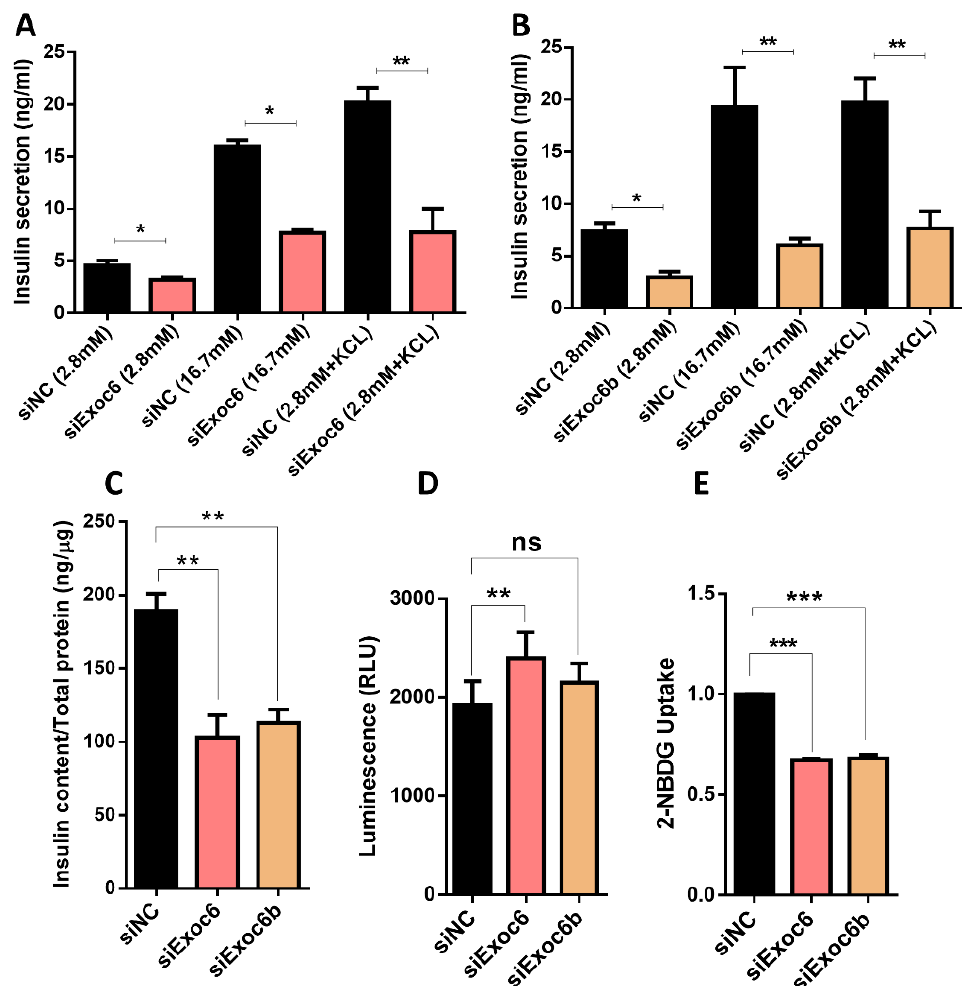
Figure 3. Impact of Exoc6/6b silencing on insulin release in INS-1 cells. ( A , B ) Measurement of insulin secretion (normalized to cellular protein content) stimulated with 2.8 mM glucose, 16.7 mM glucose, or 35 mM KCl + 2.8 mM glucose in Exoc6 ( A ) or Exoc6b ( B ) silenced cells compared to control cells. ( C ) Insulin content measurements normalized to protein content in Exoc6/6b-silenced cells compared to control cells. ( D ) assessment of ROS levels by fluorescence intensity in Exoc6/6b-silenced INS-1 cells compared to control cells. ( E ) Determination of glucose uptake in Exoc6/6b-silenced cells compared to control cells. *; p < 0.05. **; p < 0.01. ***; p < 0.001. ns.; not significant. Bars represent mean ± SD. Data are acquired from 3 different experiments.